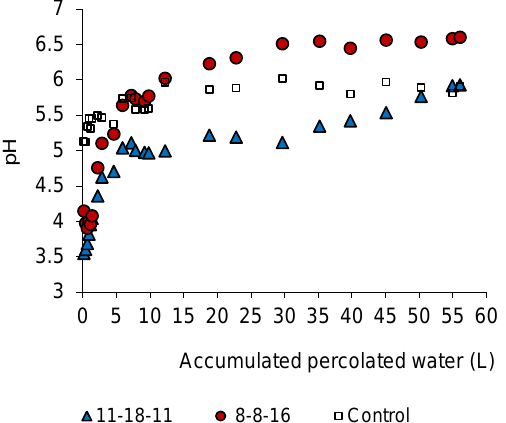
Figure 2. EC of leachates from fertilized and control columns as a function of the volume of percolated water (average of three replicates). 4